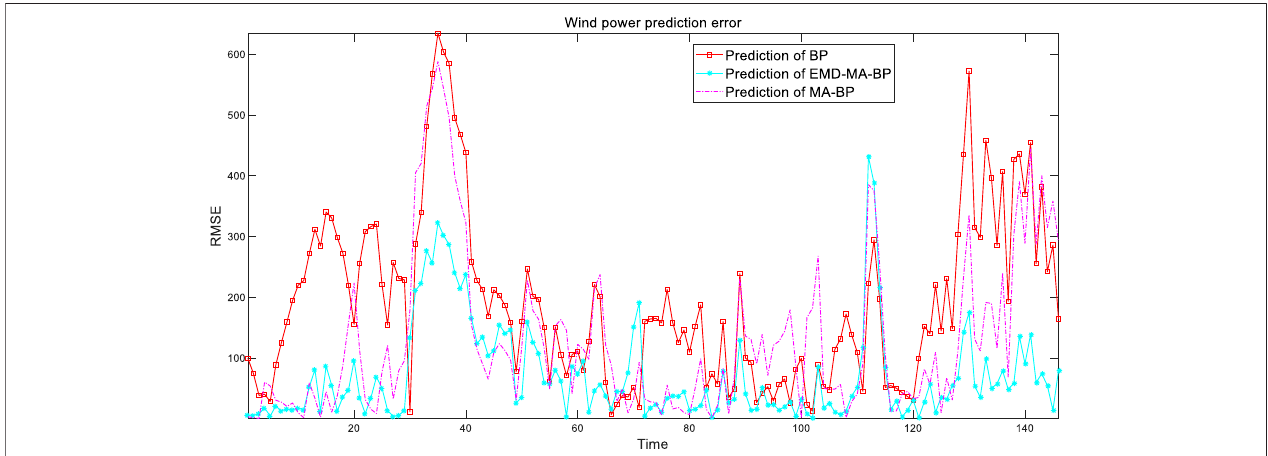
FIGURE 4 | RMSE of three wind power prediction models.